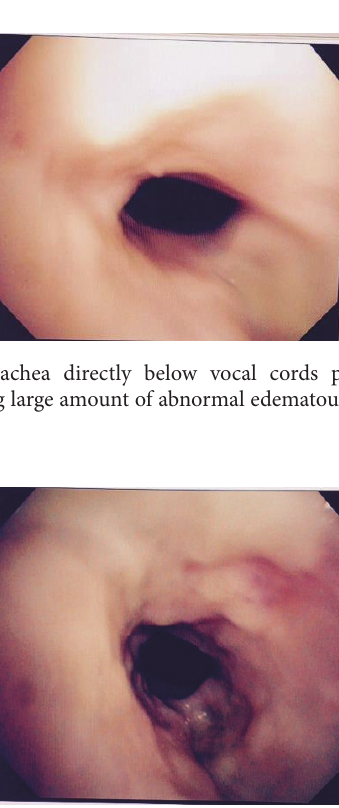
Figure 4: Closer look at area of ulceration following administration of saline.